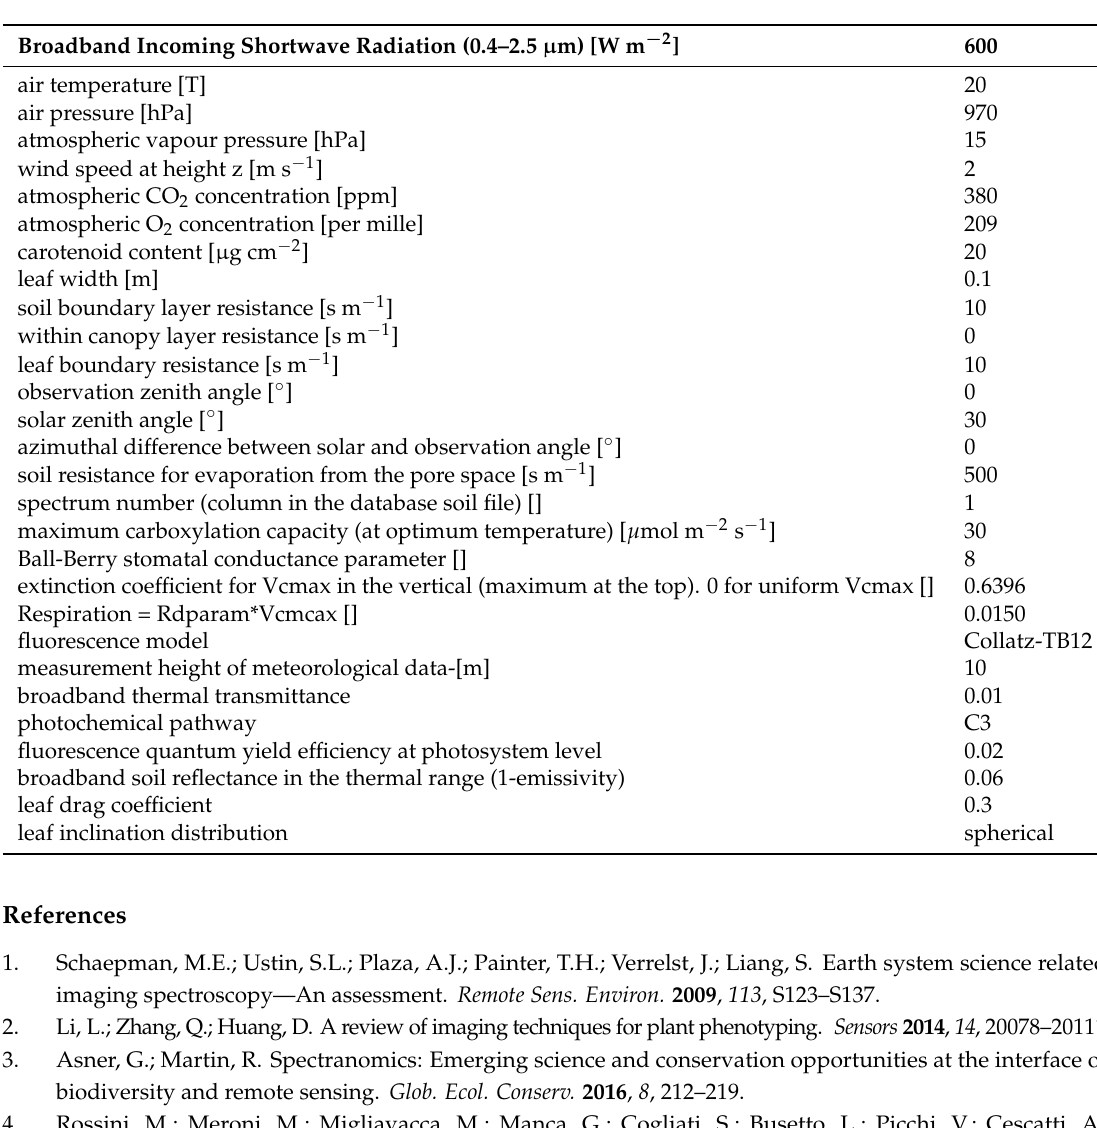
Table A1. SCOPE v. 1.61 fixed input parameters according to default